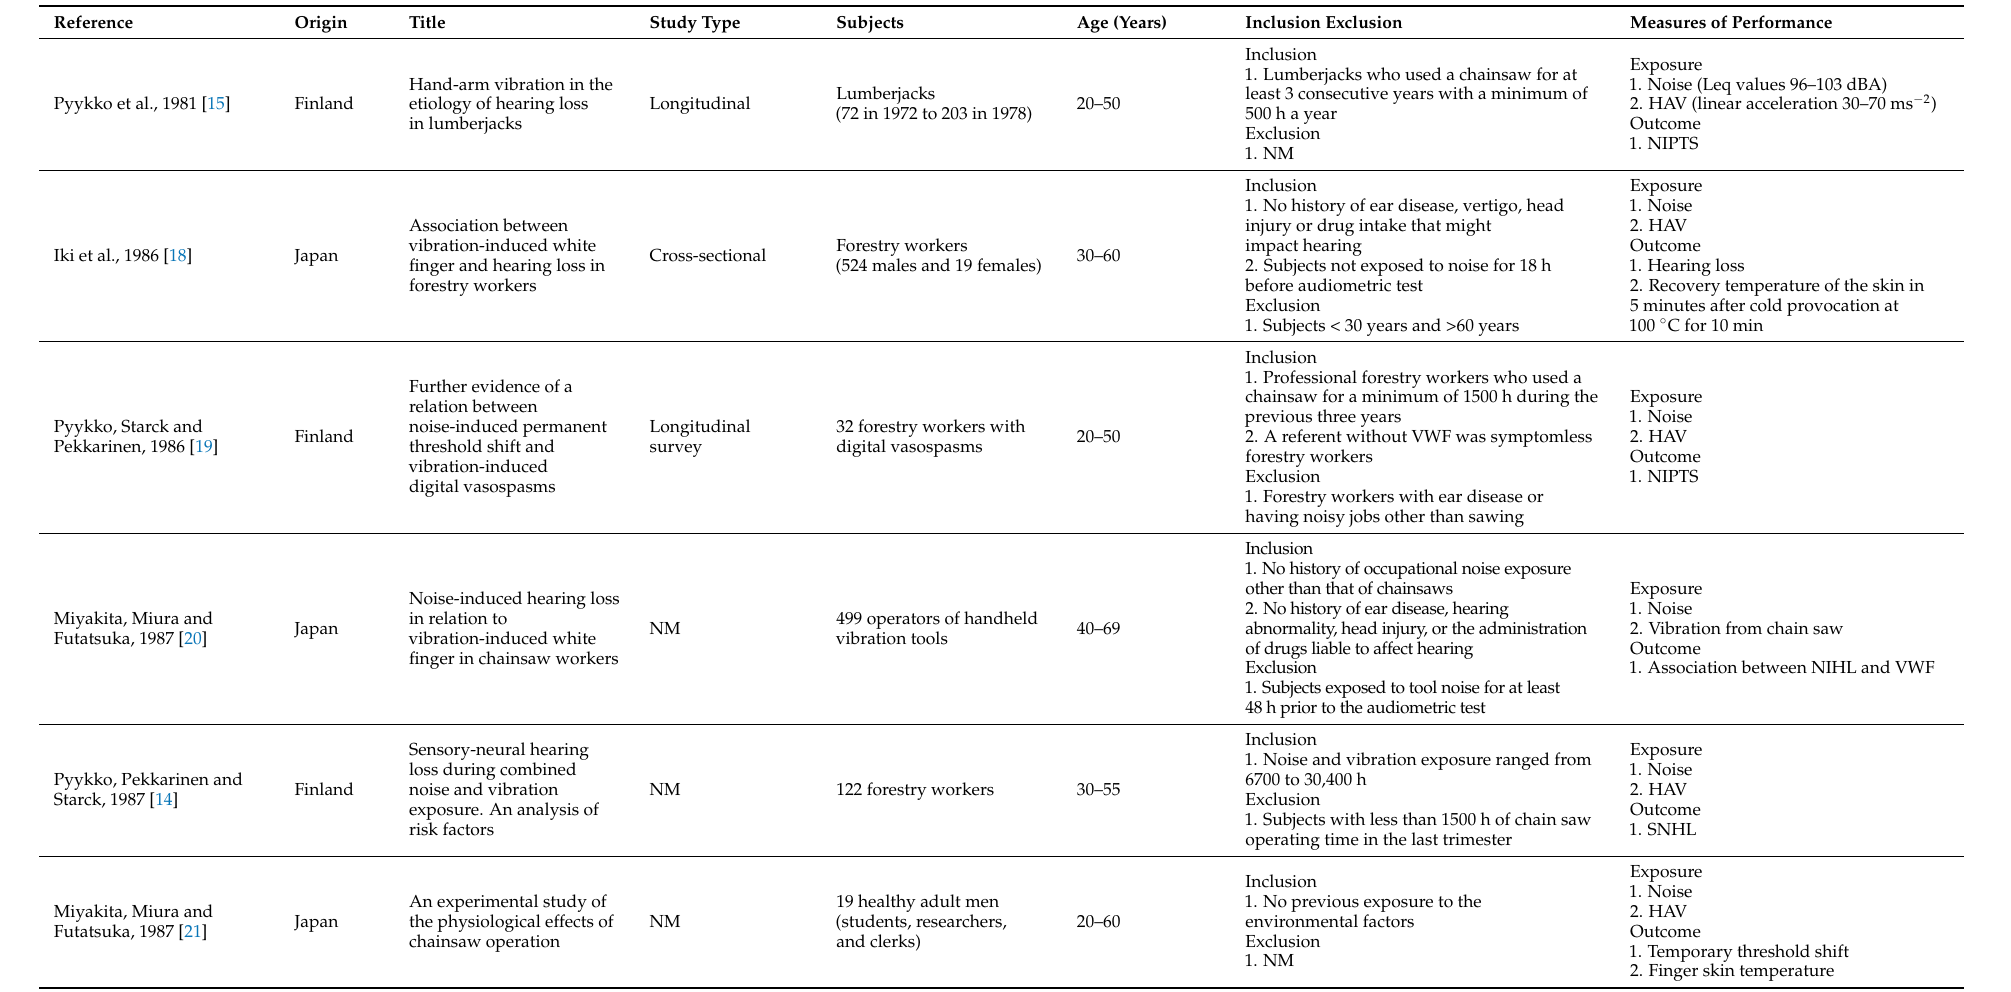
Table 1. Brief details of studies conducted by different researchers (NIPTS—Noise Induced Permanent Threshold Shift, SNHL—Sensory neural Hearing Loss, VWF—Vibration White Finger, NM—Not Mentioned, h-hours, WBV—Whole Body Vibration, NIHL—Noise Induced Hearing Loss, HAV—Hand Arm